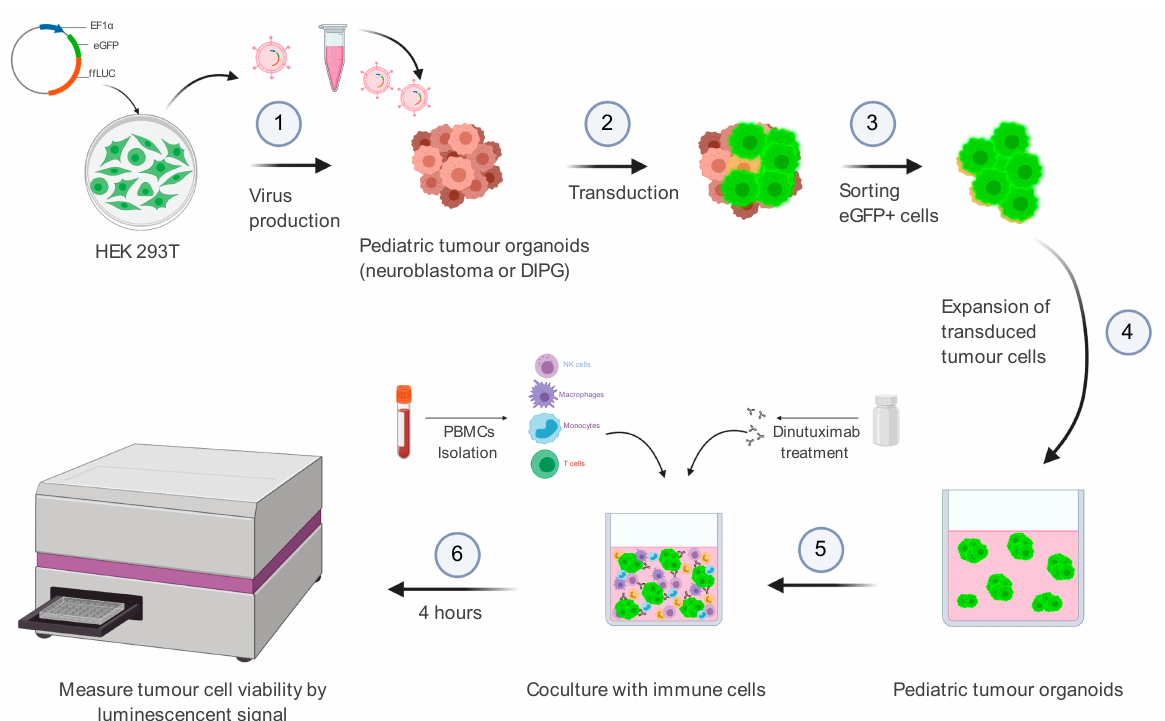
Figure 1. Schematic representation of study design and experimental workflow. Paediatric tumour organoids (neurob- lastoma and DIPG organoids) were transduced with a lentiviral vector carrying eGFP-ffLuc fusion reporter genes. eGFP expressing cells were sorted and expanded for coculture assays. Paediatric organoids were cocultured with allogenic PBMCs with/without dinutuximab treatment. The tumour cell viability was measured using the ADCC luciferase assay after the administration of D-Luciferin.